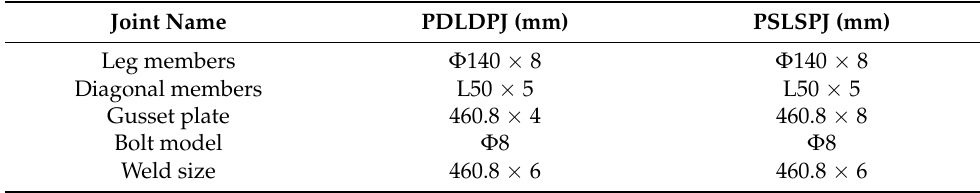
Table 1. Dimensional specifications for finite element models of PSLSPJ and